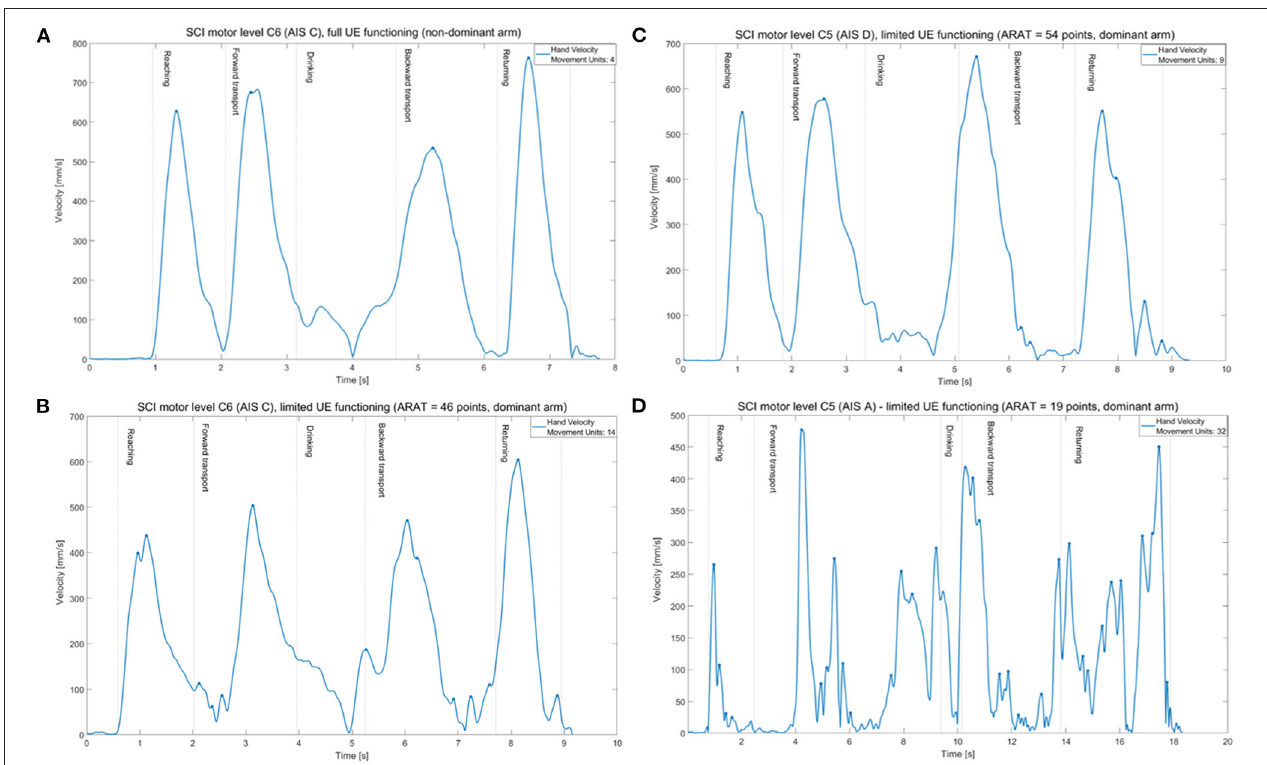
FIGURE 3 | Tangential velocity profiles (hand marker) and number of movement units (marked as dots) of the drinking task shown in one individual from full functioning group (A) and three individuals from limited functioning group with different levels of functioning after SCI (B–D) . both in reach-to-grasp (15) and drinking task (21), but no differences were found between the C6 and C7 groups